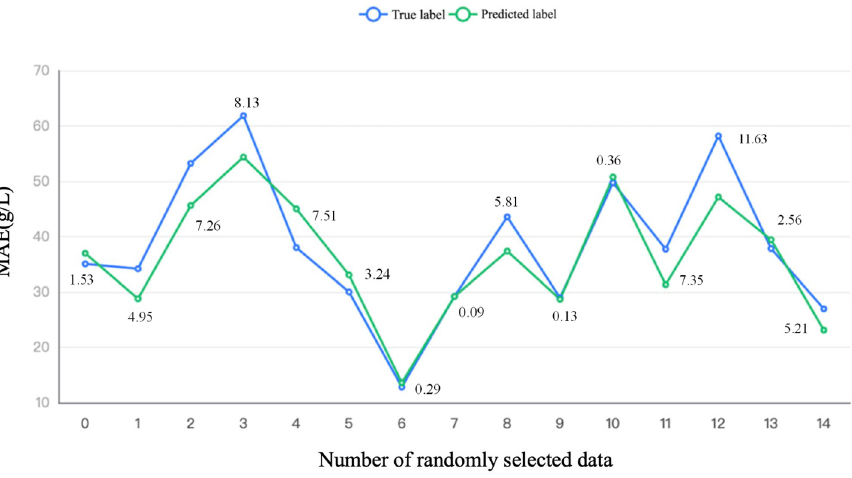
Figure 2. The prediction result of the bp neuron network of different substrates on PMLA produc-